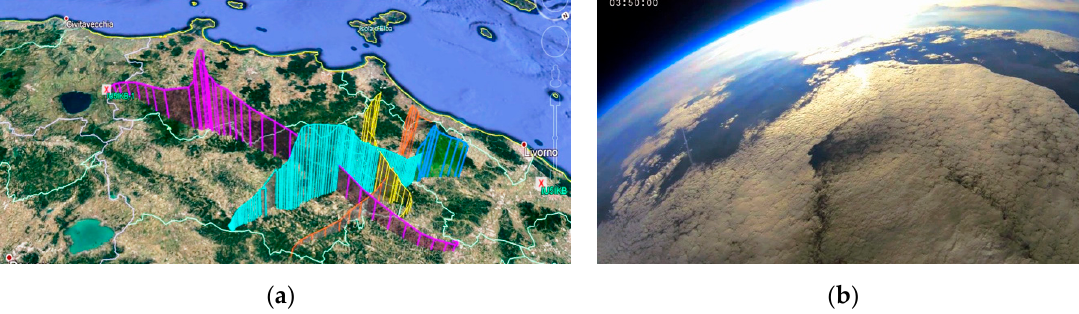
Figure 9. Simulated trajectory (red) vs. real trajectory (blue).